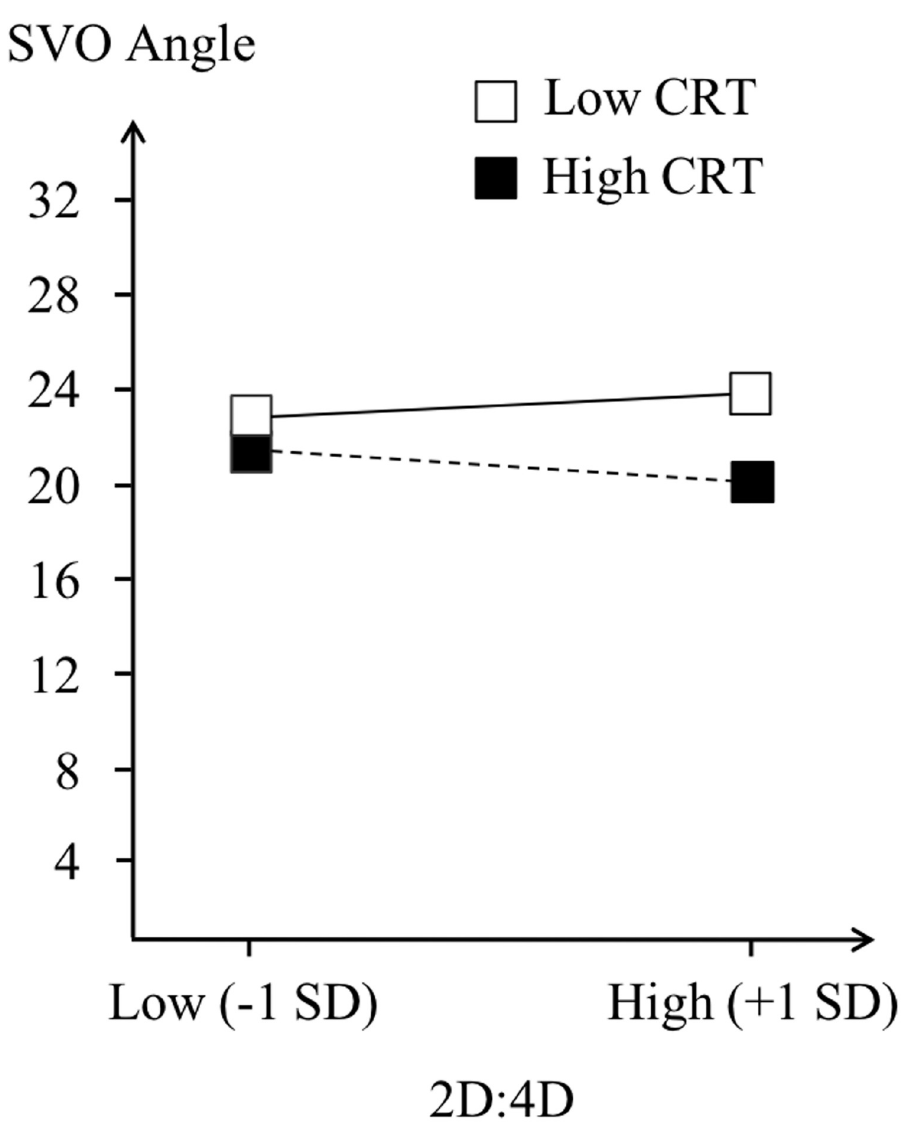
Fig 2. SVO as a function of 2D:4D and CRT (Right-hand male